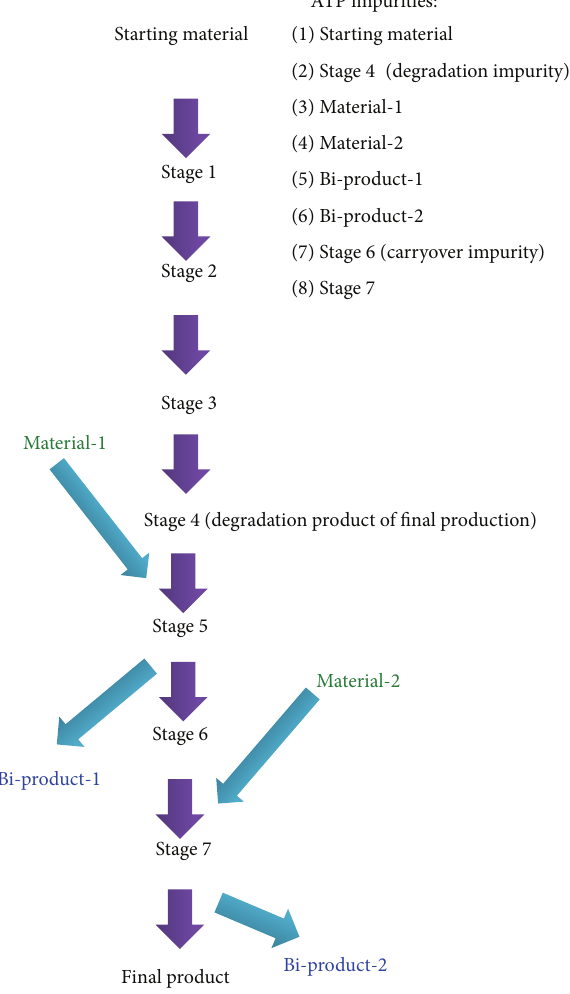
Table 2: Common ATPs for impurity profile by HPLC